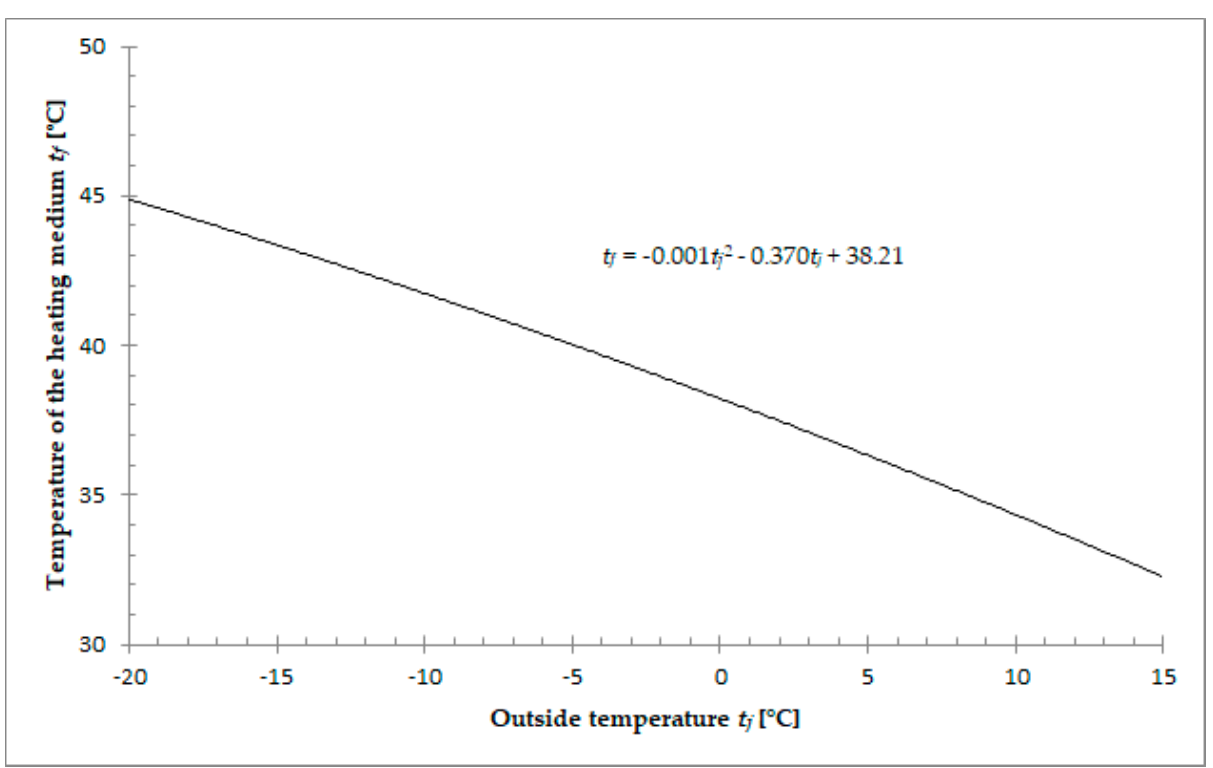
Figure 1. The heating curve applied in the heating system based on [42].